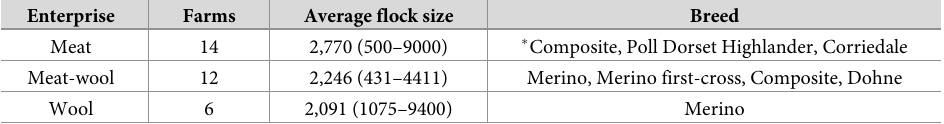
� Composite breeds were mainly Coopworths (Border- Romney, F3 generation progeny). Merino first-cross ewes refer to the offsprings of Merino ewes with Border Leicester